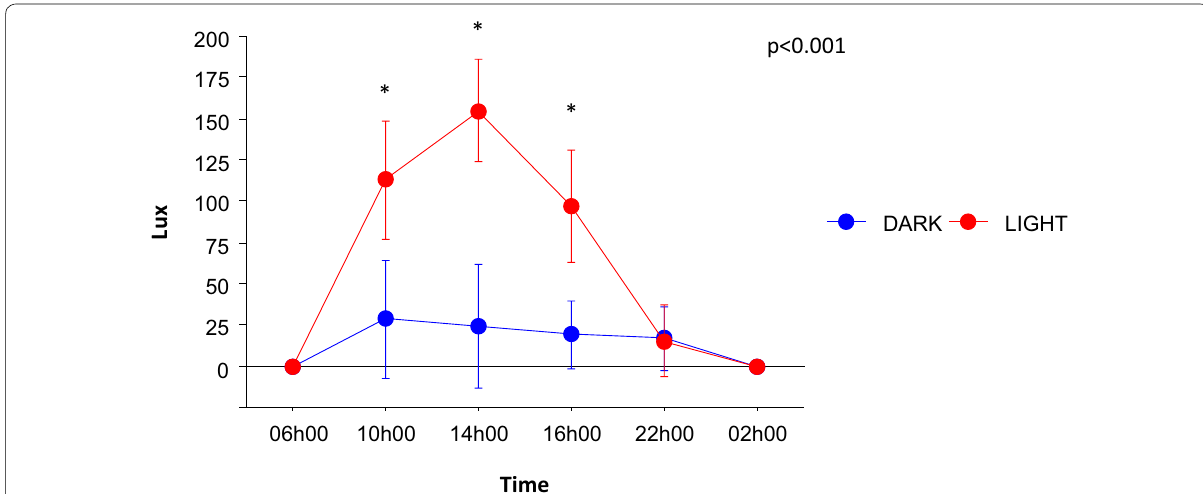
Fig. 1 Illuminance (lux) measured at different hours of the day in rooms with windows (LIGHT group) or without windows (DARK group). Data presented as mean and 95% confidence interval. p ‑value was obtained by repeated measures ANOVA for overall significance of the difference in time course of lux (time * group interaction). * p < 0.05 for LIGHT versus DARK